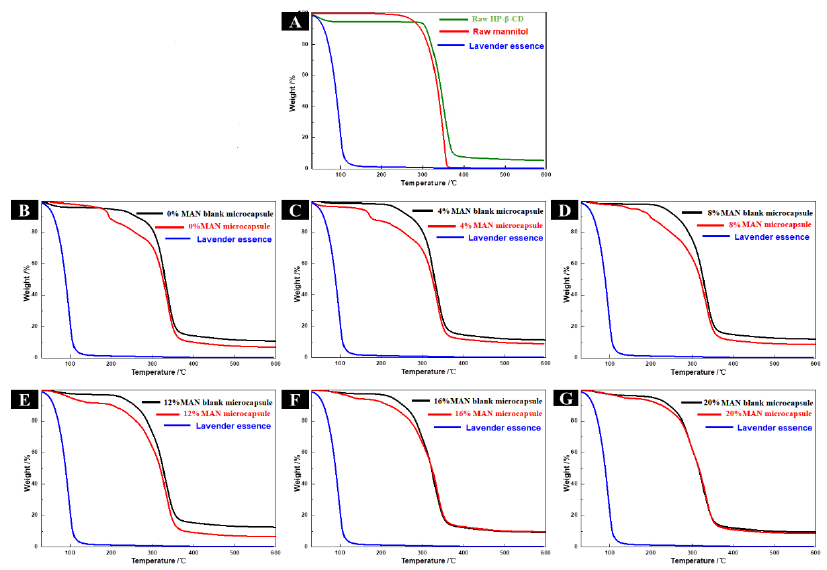
Figure 7. Thermal gravimetric analysis curves of ( A ) raw materials and ( B – G ) HP- β -CD/MAN microcapsules. ( B ) to ( G ) show results for HP- β -CD/MAN microcapsules with 0%, 4%, 8%, 12%, 16%, and 20% MAN ratios, respectively.